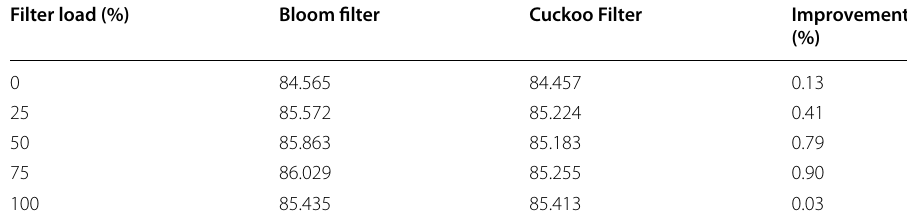
Table 5 Experimental results 1: Insertion performance. Query execution time in seconds Filter load (%) Bloom filter